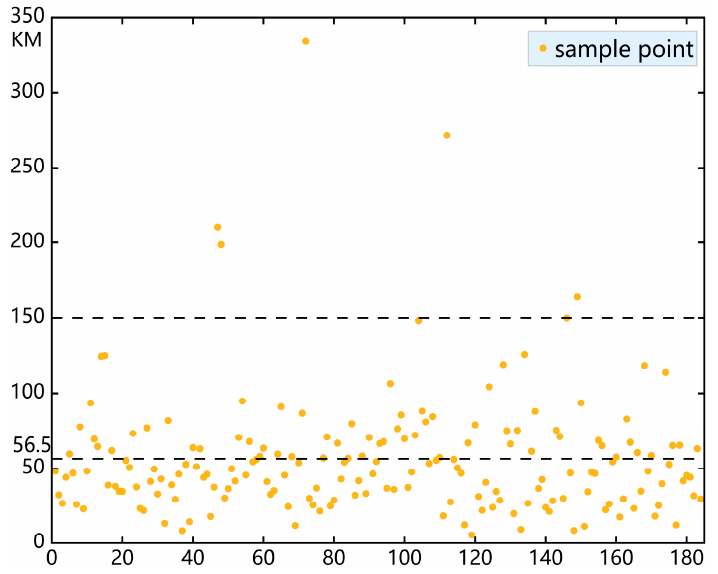
Figure 9. The distance between the location of wildfires in the MODIS_DT_Fire dataset and the meteorological station sites. The horizontal dashed line represented by 56.5 in the figure is the average of the distances.